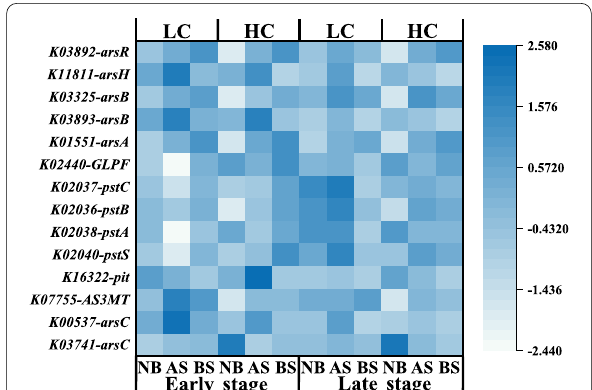
Fig. 5 Heatmap of the functional genes. Darker and lighter blue indicate the relative abundance of each gene in different samples depending on Z-score. LC: Low concentration; HC: High concentration; NB: Microbial samples in “No BC” systems; AS: Microorganism suspended in the aqueous solution; BS: Microorganism colony attached to the biochar